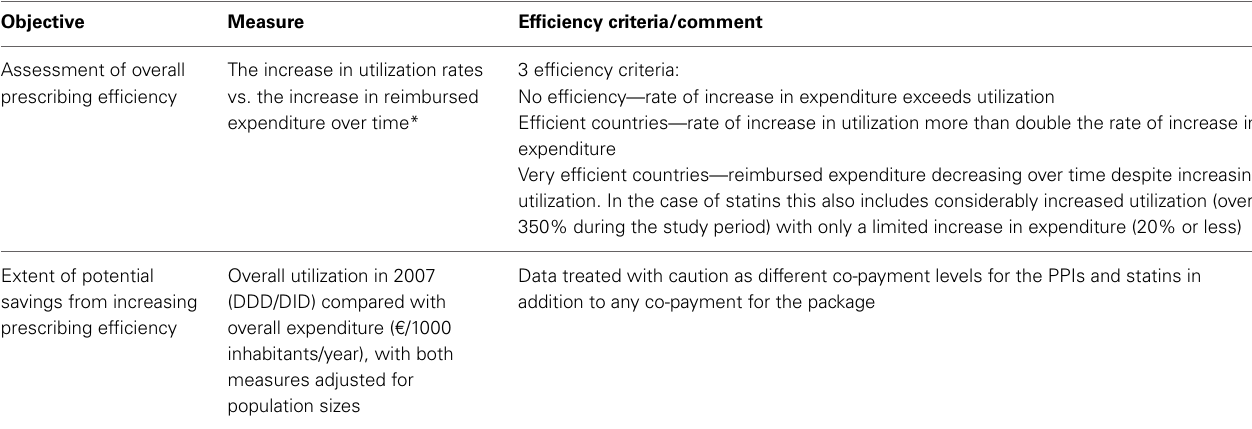
Table 1 | Principal measures used to evaluate changes in prescribing efficiency for both the PPIs and statins during the study years as well as categorize countries (Godman et al.,